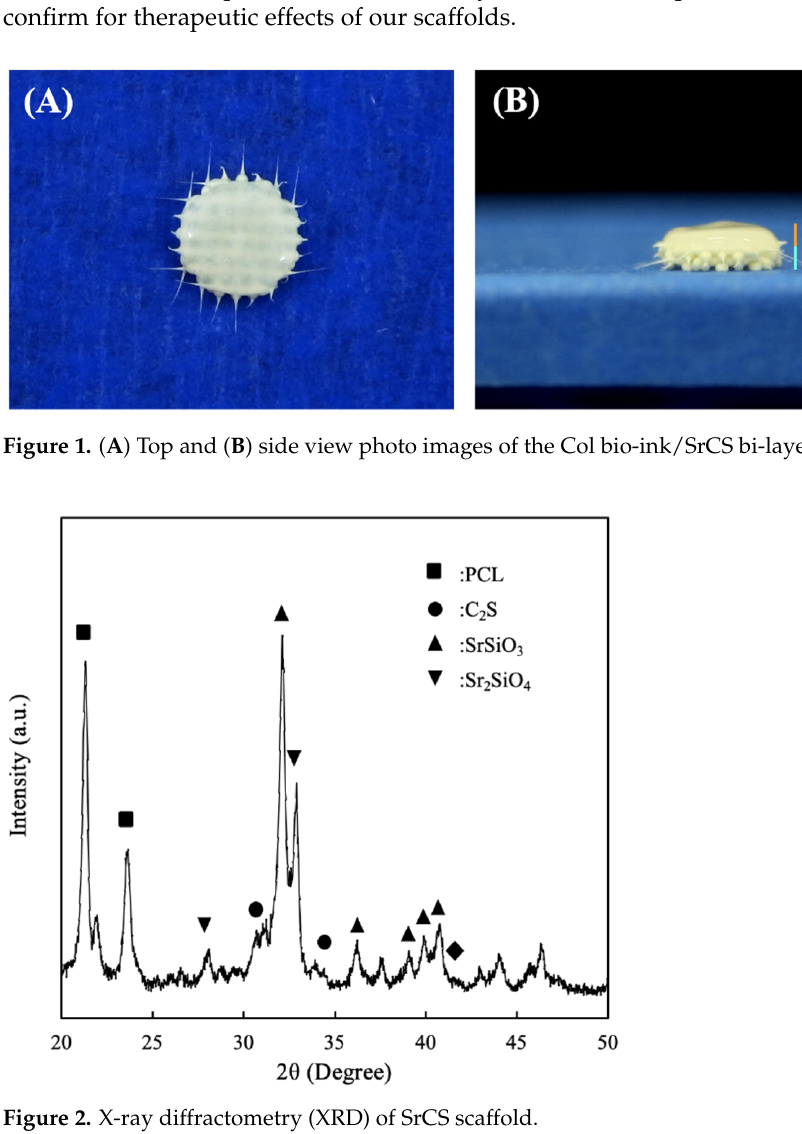
Figure 1. ( A ) Top and ( B ) side view photo images of the Col bio-ink/SrCS bi-layer scaffolds.